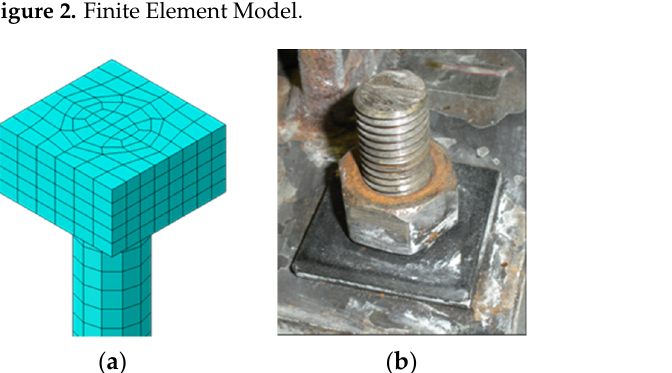
Figure 3. Simulation of the anchor bolt with washer and nut: ( a ) FE model and ( b ) experimental